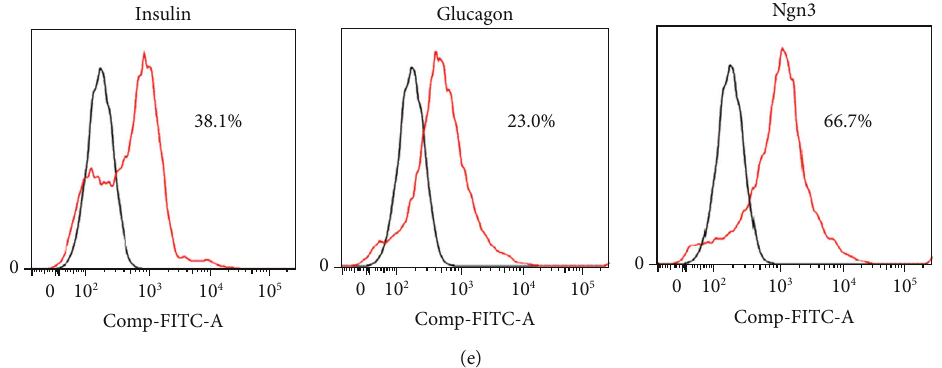
Figure 4: Di ff erentiation of pancreatic progenitor cells into IPCs. (a) Final stage of di ff erentiation using forskolin, dexamethasone, and nicotinamide to induce di ff erentiation into IPCs. (b) The insulin and glucagon expression in induced cells assessed using qPCR after 10 d is the highest in cells incubated with SANT-1. The expression pro fi les of Pdx1 and Nkx6.1 were similar ( n = 3 ). (c) Immunostaining of cells expressing insulin or glucagon on day 10 of di ff erentiation step 3. (d) Insulin or Pdx1 expression on day 10 of di ff erentiation step 3. (e) Distribution of cells expressing insulin, glucagon, and Ngn3 in di ff erentiated cells analyzed by